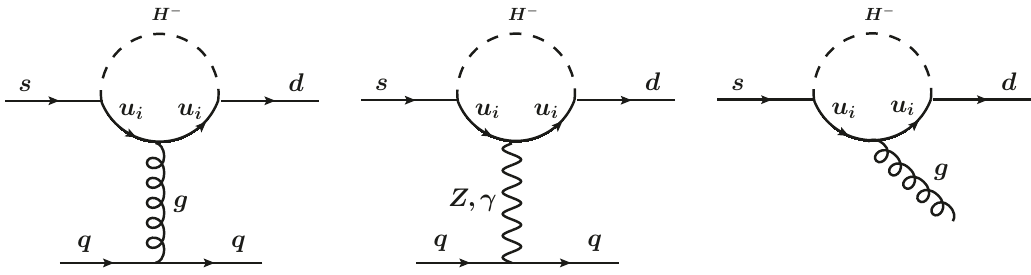
Figure 2 . H ± induced contributions to ε 0 /ε in g2HDM. Another variant of the second diagram where Z, γ propagators couple to H − is not